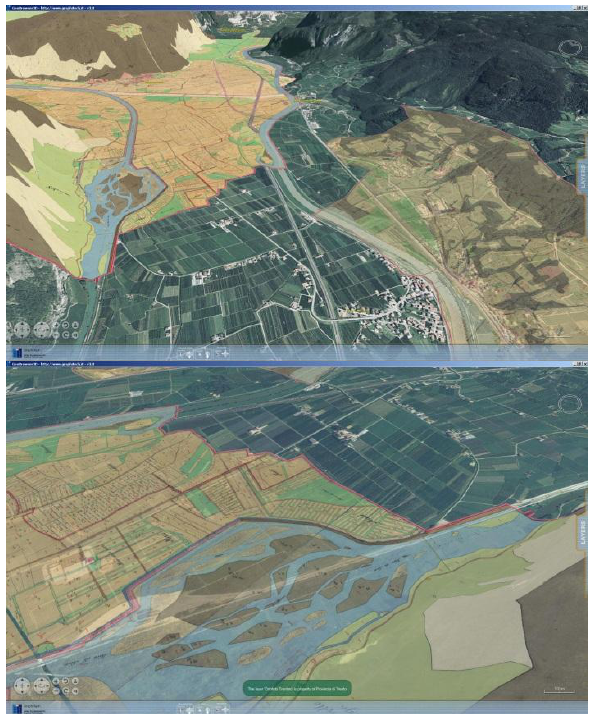
Figure 1: the system in use while showing the historical